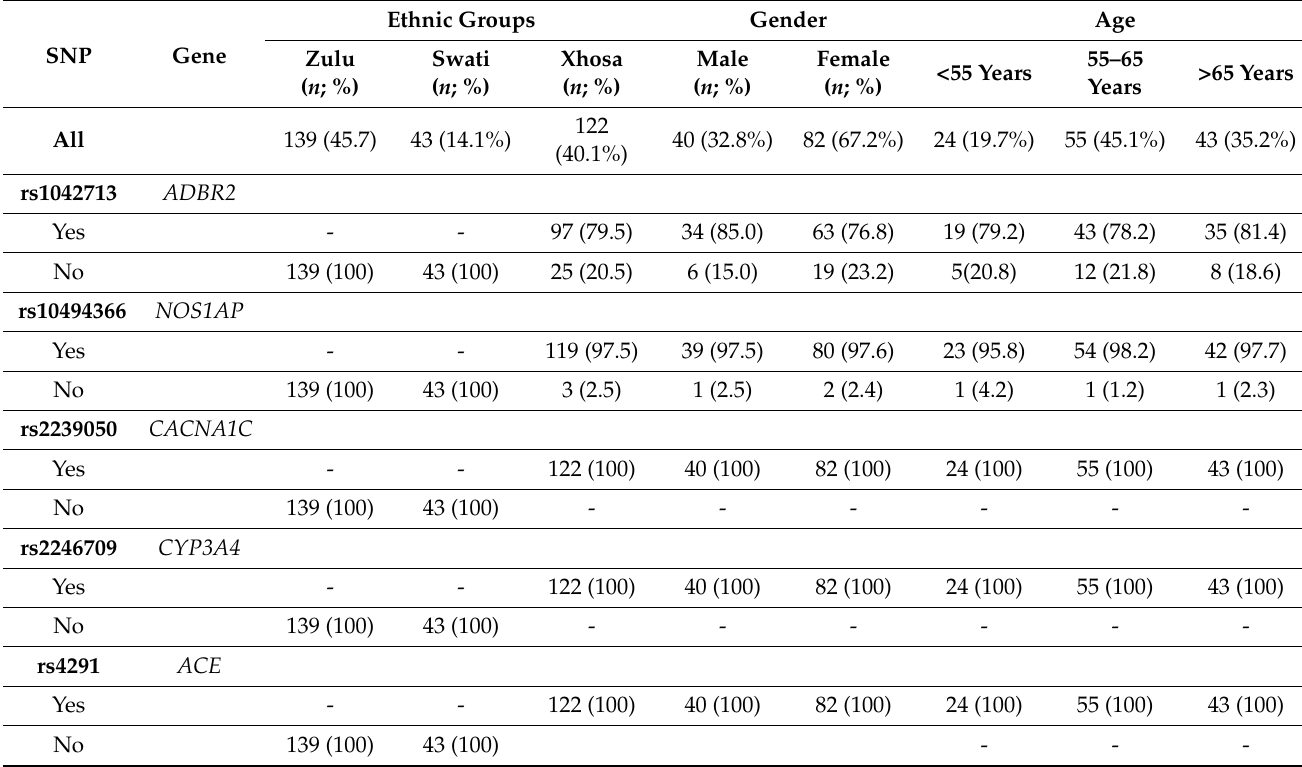
Table 3. Distribution patterns of selected single nucleotide polymorphisms